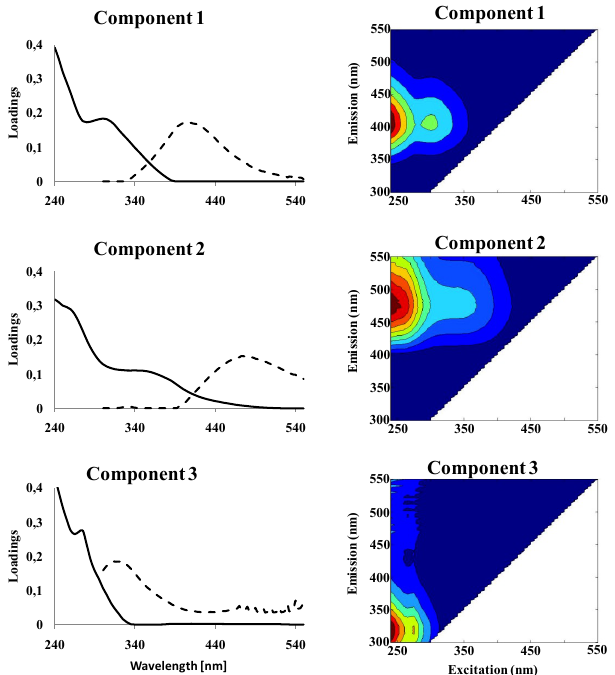
Fig. 8. Emission (dashed line) and excitation (solid line) spectra Figure 8 . Emission (dashed line) and Excitation (solid line) spectra (left panels) and contour 774 (left panels) and contour plots (right panels) of the three main fluo- plots (right panels) of the three main fluorescent components identified in the d ataset (n = 54). 775 rescent components identified in the data set ( n = 54). Ex/Em com- ponent 1: 240 (300)/404; Ex/Em component 2: 240 (340)/472 and Ex/Em Component 1: 240 (300)/404; Ex/Em Component 2: 240 (340)/472 and Ex/Em 776 Ex/Em component 3: 240